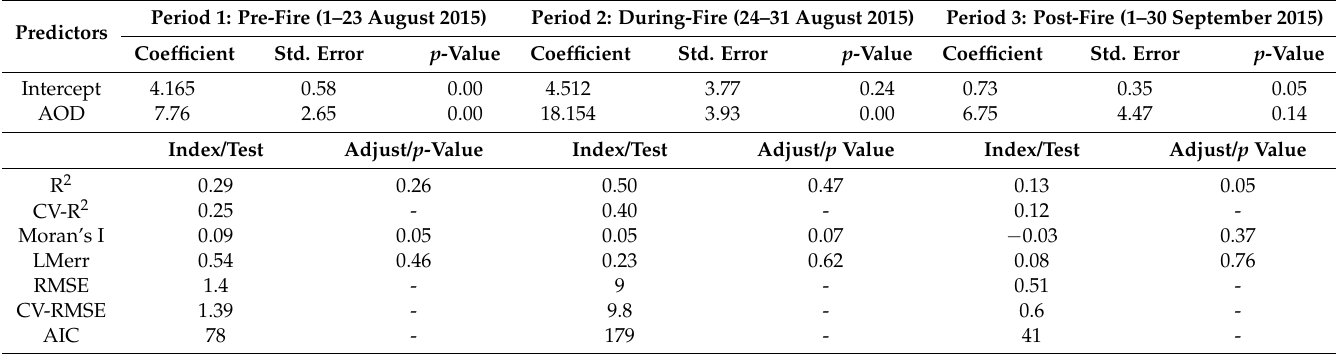
Table 3. Results of aerosol optical depth (AOD)-based model for three periods.